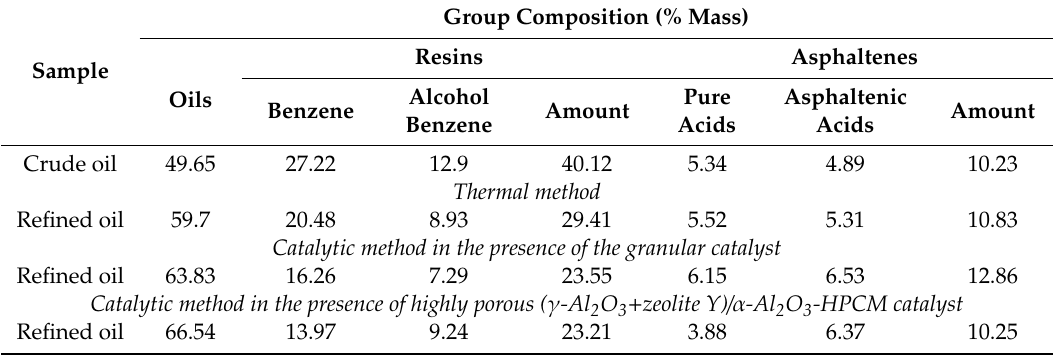
Table 5. Data of the group composition of crude and refined oil according to liquid adsorption chromatography